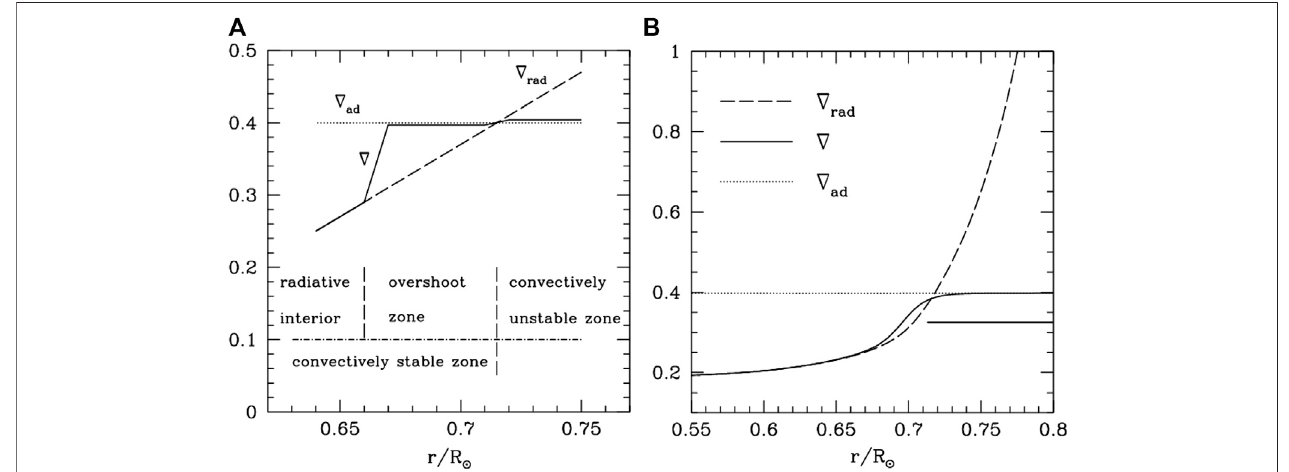
FIGURE6| Thetemperaturegradient ( ∇ ) ,theradiativegradient ( ∇ rad ) ,andtheadiabaticgradient ( ∇ ad ) versusthefractionalradius r / R ⊙ nearthebottomboundary ofthesolarconvectionzone.Panel (A) :asketchforthenon-localMLTmodel;Panel (B) :thesameasforpanel (A) ,butforournon-localconvectionmodel.Thehorizontal black line shows the range of the convectively unstable